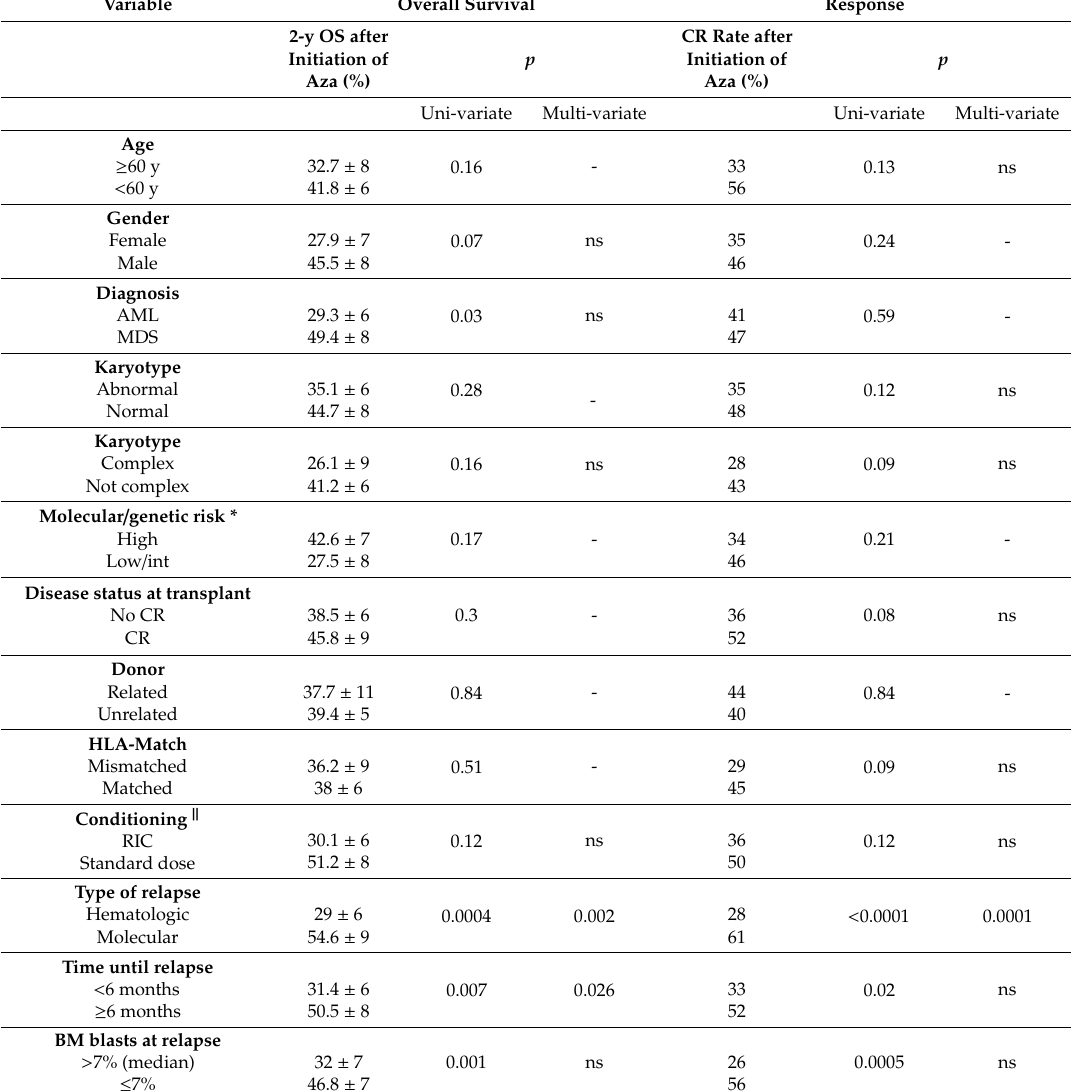
Table 3. Impacts of clinical parameters on response and outcome after treatment with azacitidine for posttransplant AML and MDS relapse—univariate and multivariate Analysis (n = 151). Variable Overall Survival Response